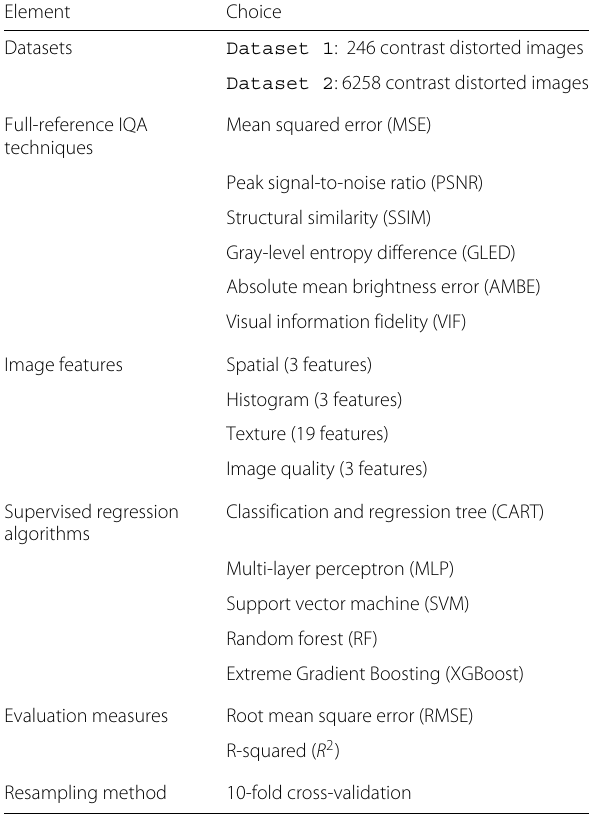
Table 3 Experimental